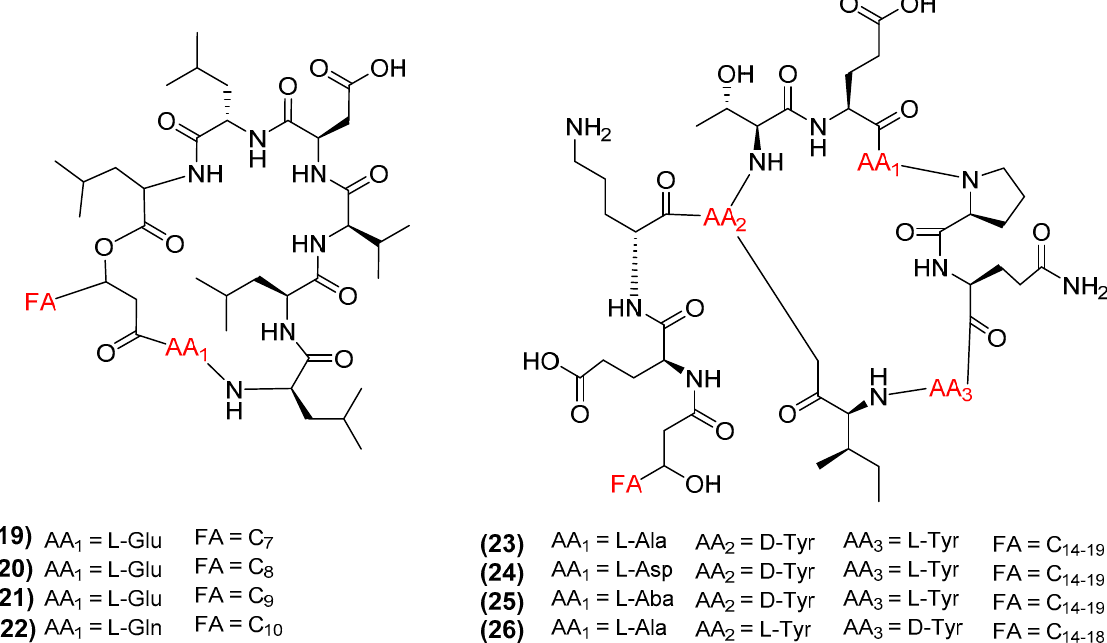
Figure 6. Chemical structures of surfactin A–C ( 19 – 21 ), lichenysin ( 22 ), and fengycin A–D ( 23 – 26 ). Iturins (27–30) (Figure 7) are cyclic lipopeptides that includes iturin A (27), bacillo- mycin D (28), bacillomycin L (29), and mycosubtilin (30) [77]. These peptides primarily